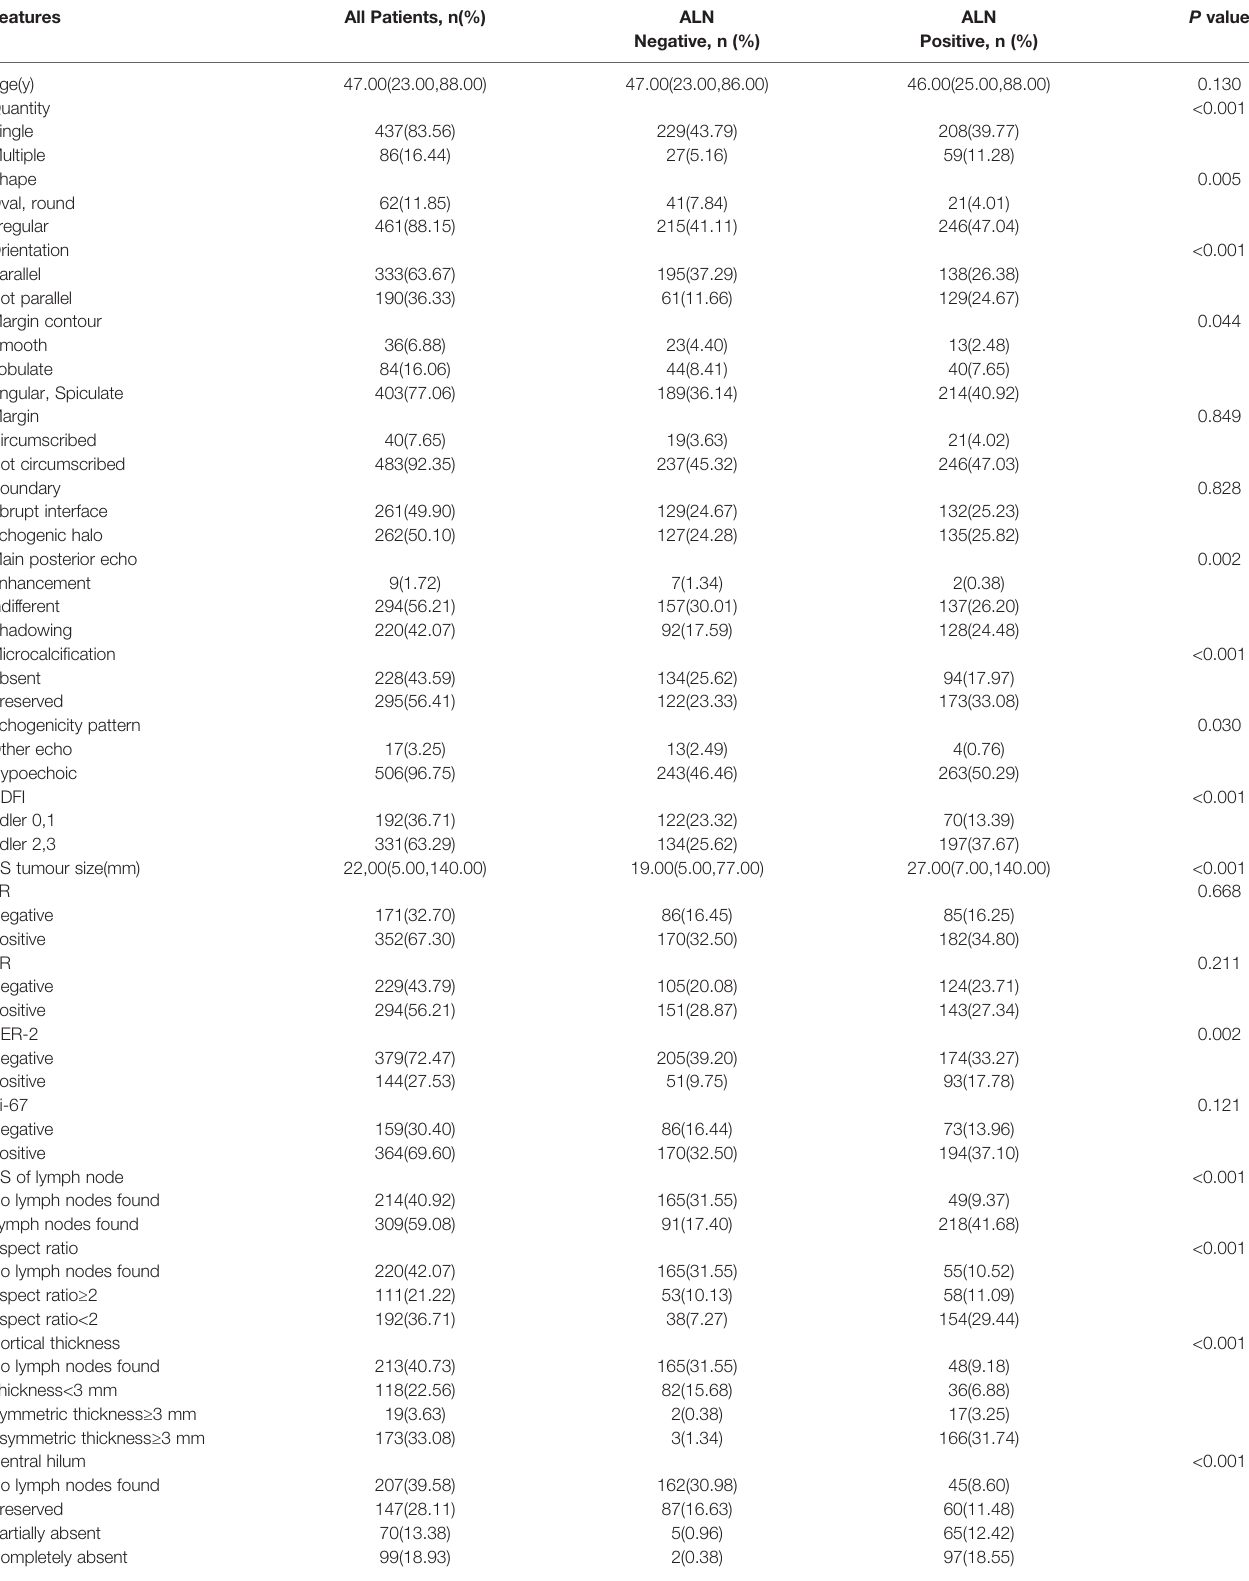
TABLE 2 | Critical predictors obtained by univariate logistic regression analysis.